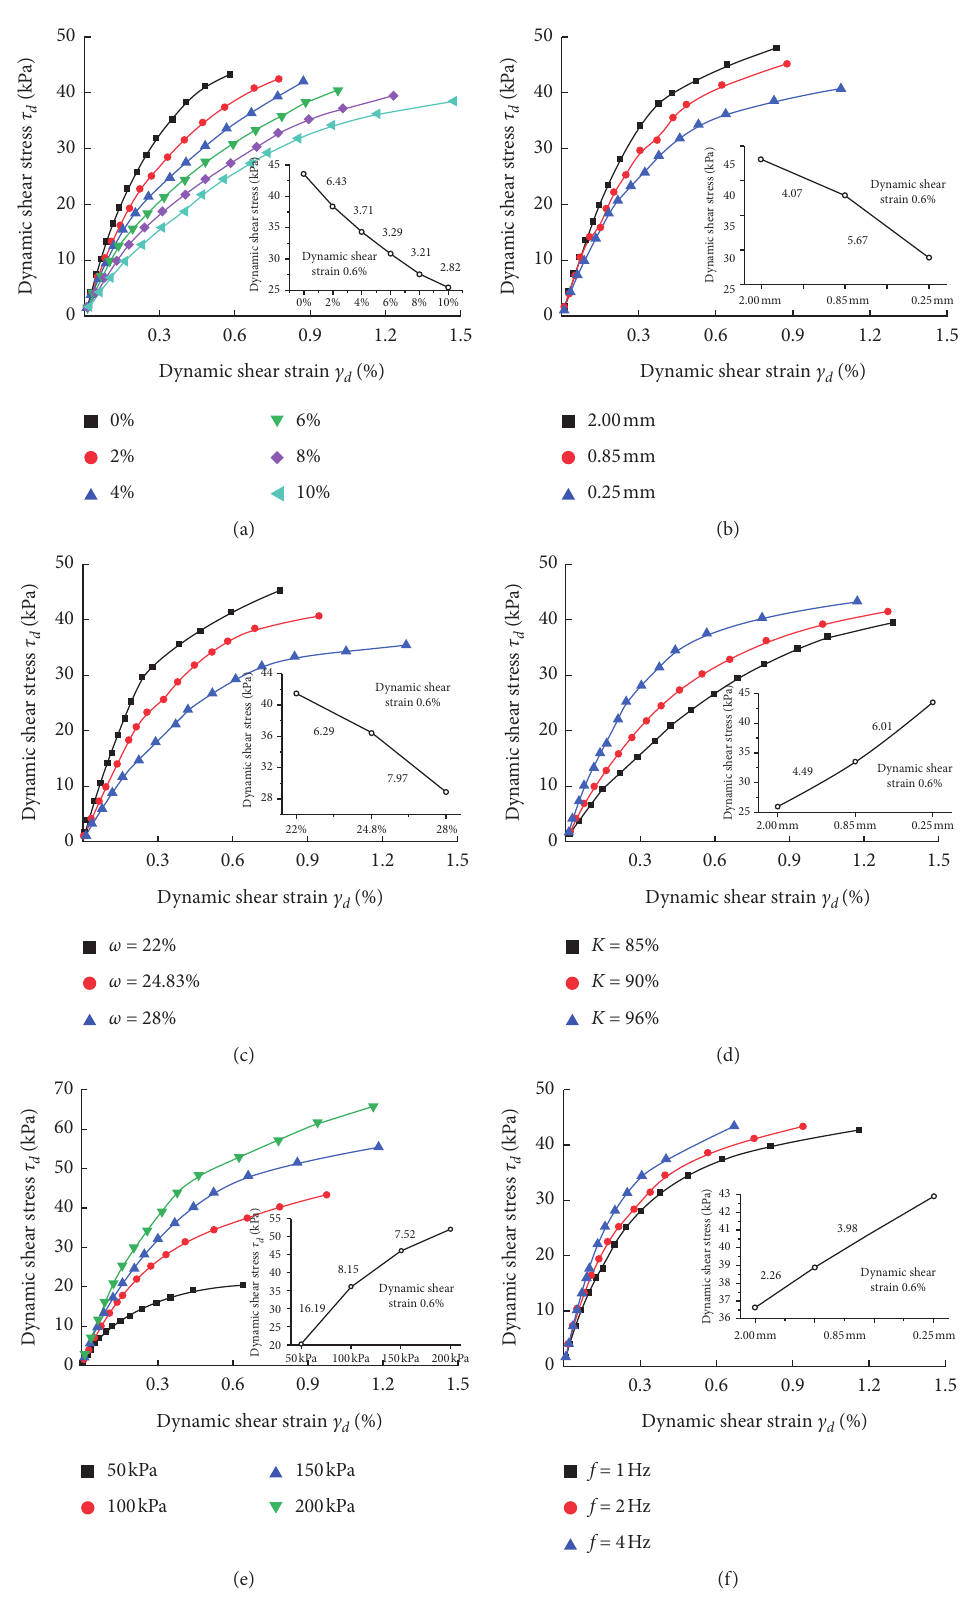
Figure 6: Dynamic shear stress-shear strain curve of rubber-red clay. (a) Rubber powder content; (b) rubber particle size; (c) moisture content; (d) compactness; (e) confining pressure; (f)